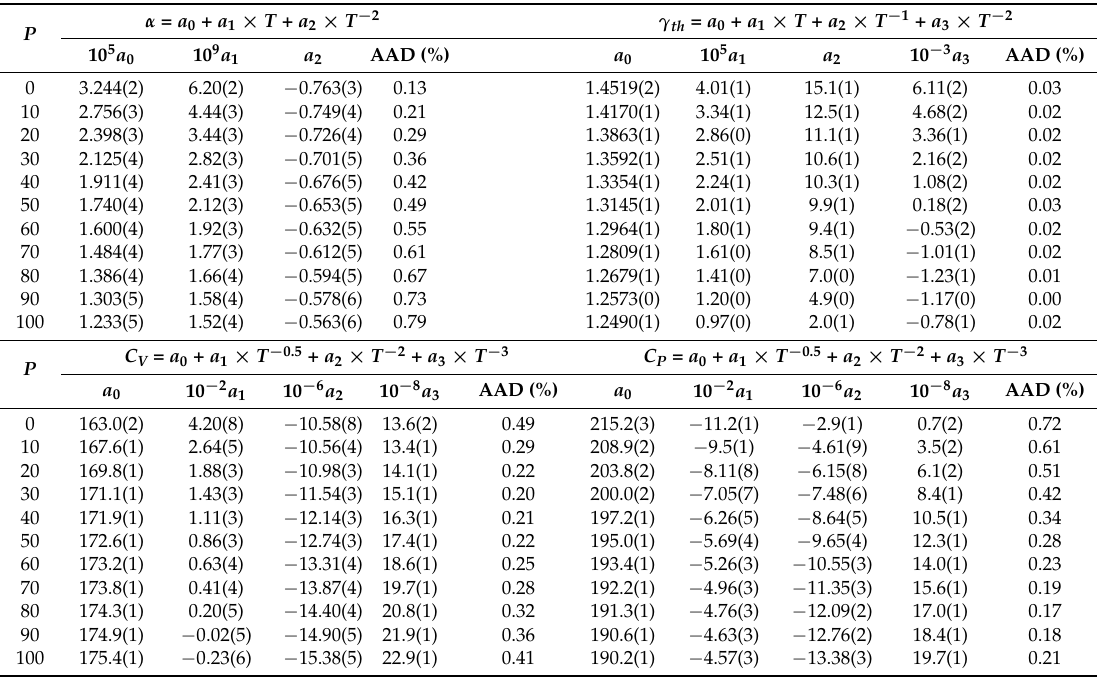
Table 8. Polynomial fitting results for α , γ th , C V and C P from 300 to 1500 K at different P (GPa), calculated using the LDA